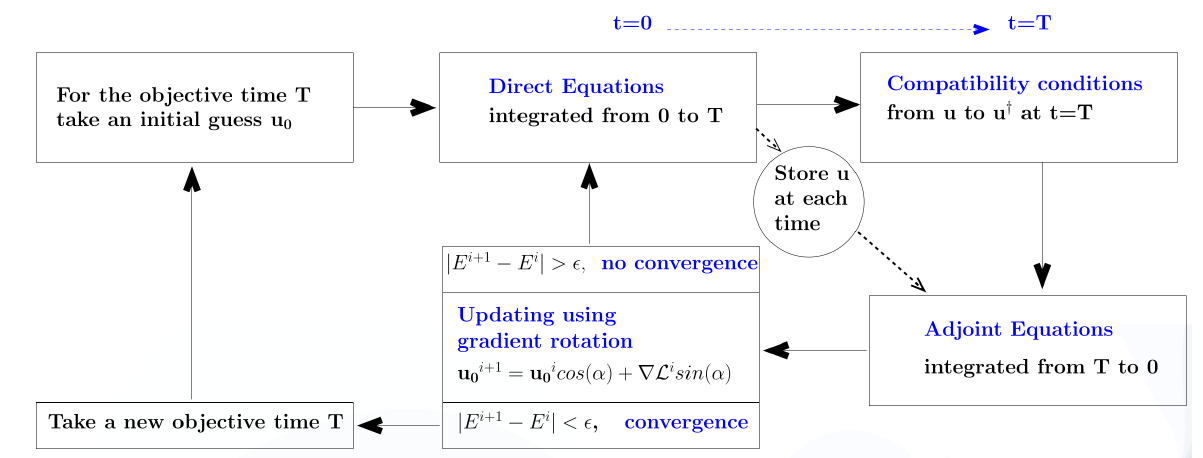
Figure 3. Schematic of the direct-adjoint looping procedure using gradient